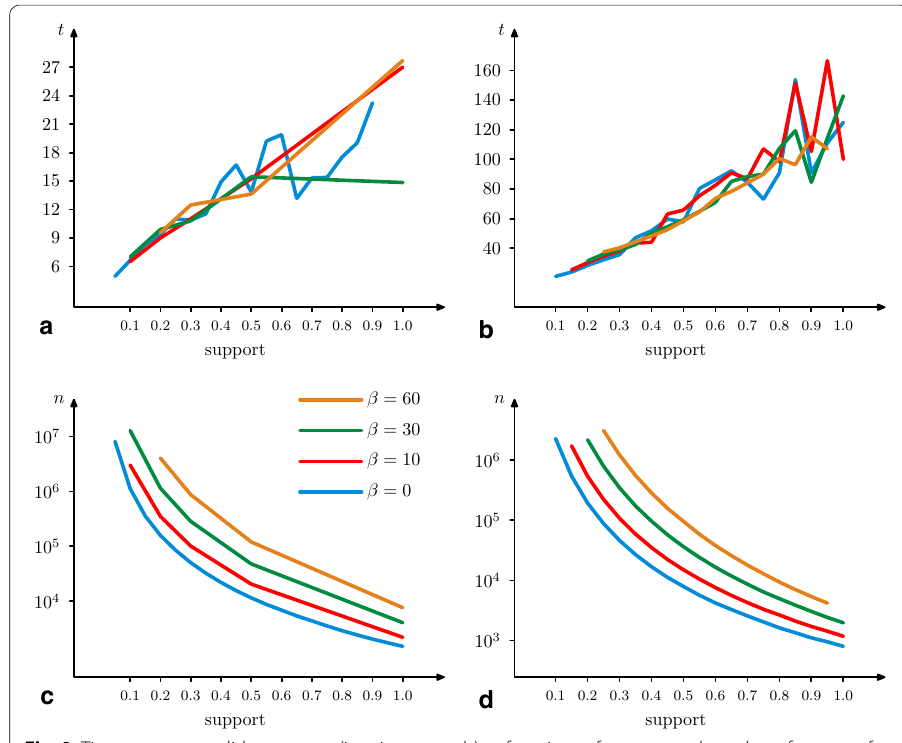
Fig. 9 Time per one candidate pattern (in microseconds) as functions of support and number of patterns for different values of β . a , c Expensive care and b , d non-expensive